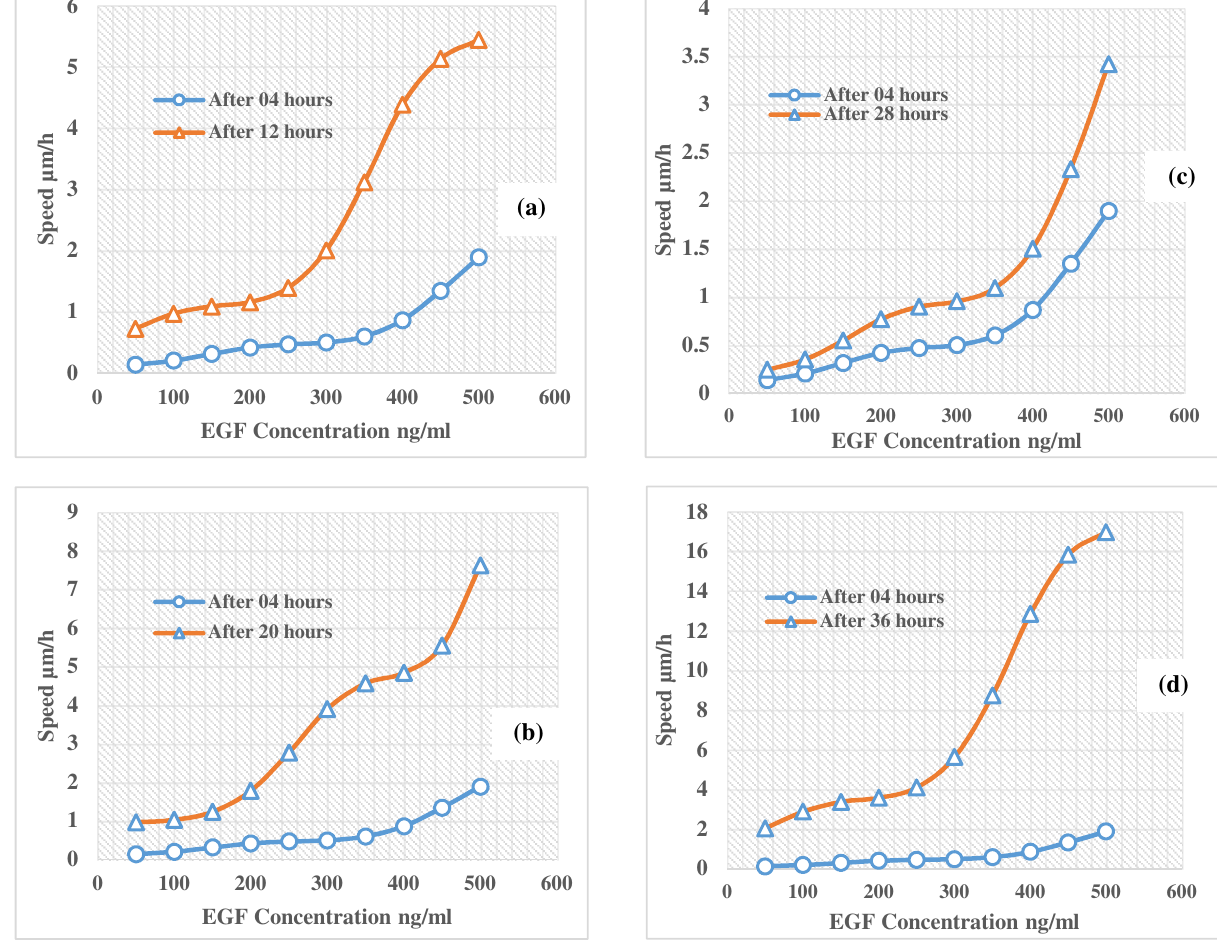
Fig. 11. Radial speed of healing with respect the cell concentration of EGF for 4 steps: (a) 12h, (b) 20h, (c) 28h and (d) 36h compared with 4 hours.